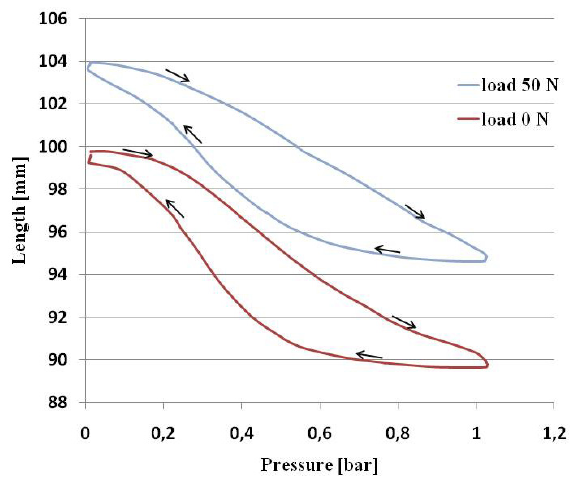
Figure 10. Length-pressure tests on a textile muscle.